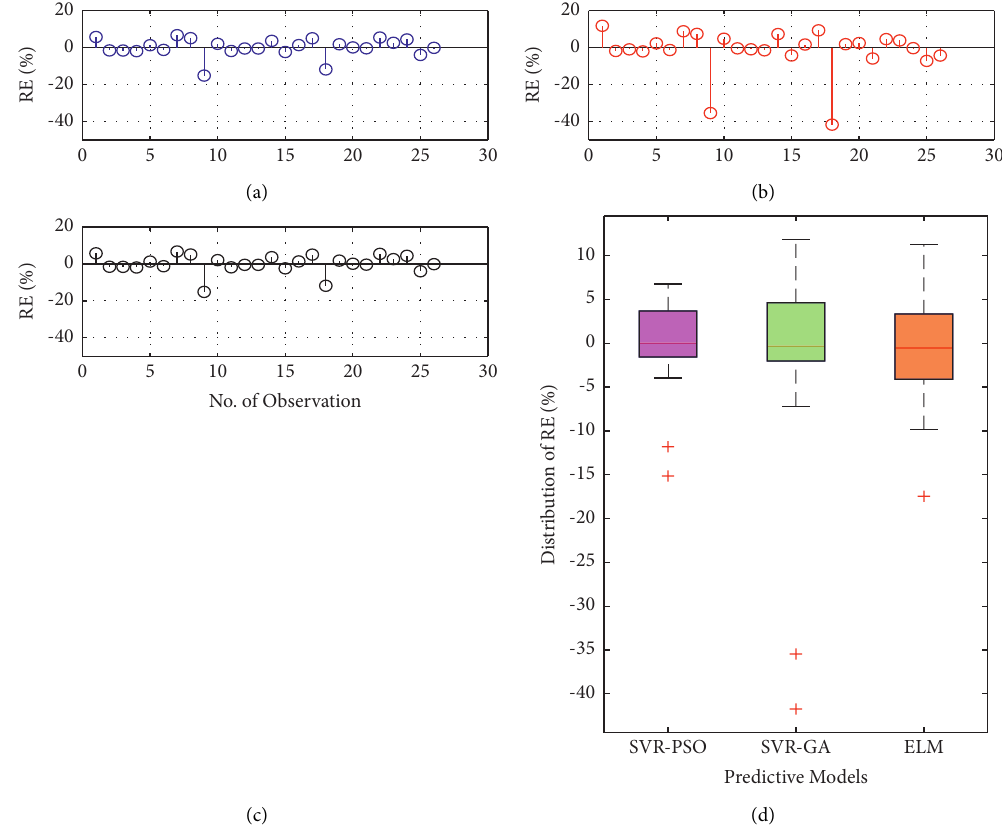
Figure 6: Comparison of the performances of three adopted models: (a, b, and c respectively belong to SVR-PSO, SVR-GA, and ELM, while d shows the boxplot presentation for illustrating the distribution of relative error for all adopted models in a single plot.